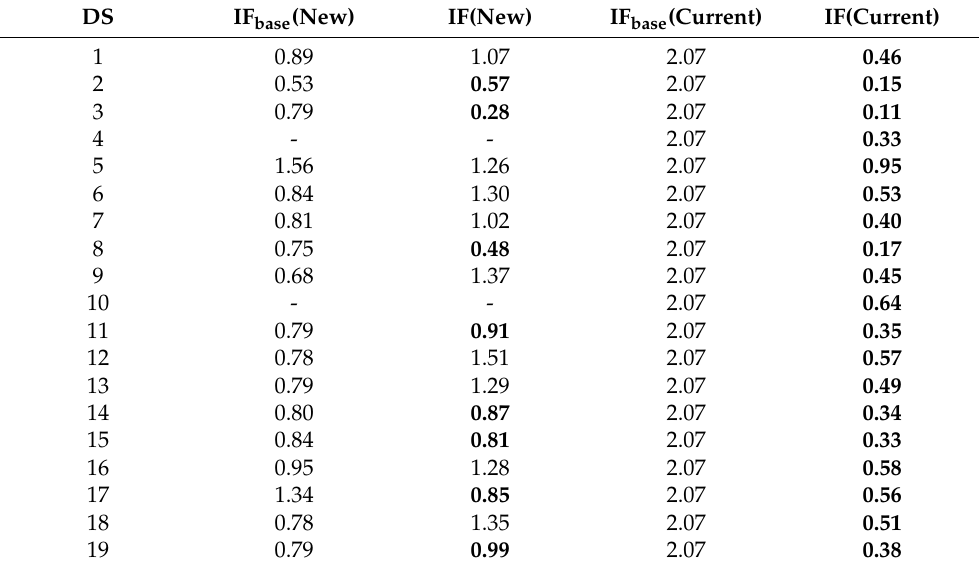
Table 9. IF base and IF of distribution systems. DS IF base (New)